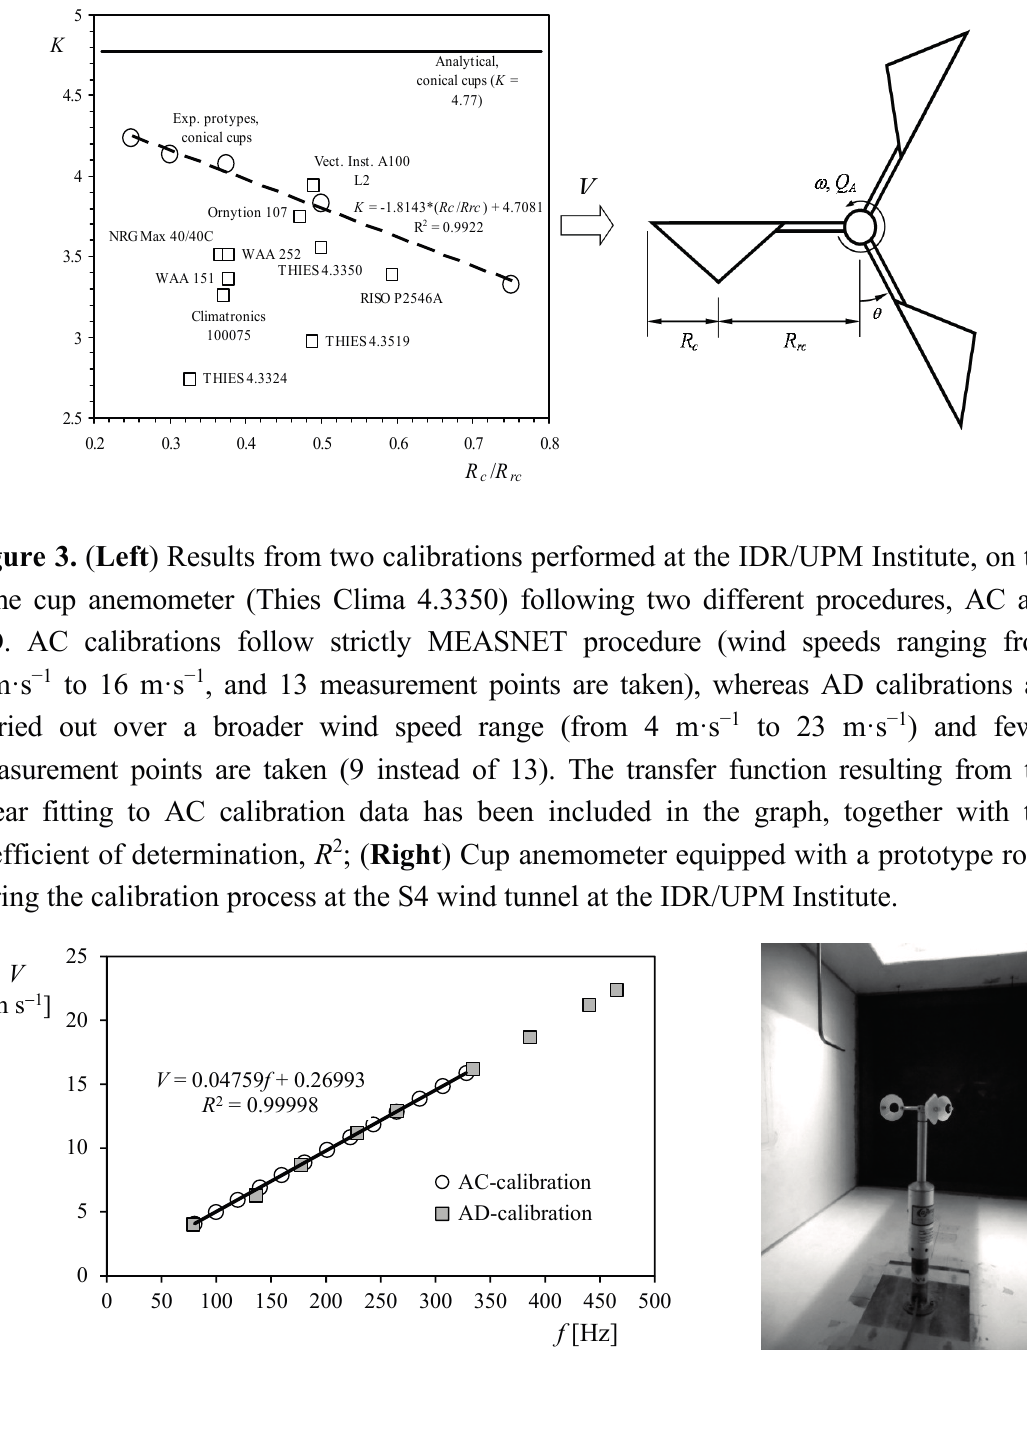
Figure 2. Cup anemometer factor, K (defined as K = V /2 π f r R rc , where V is the wind speed, f r is the anemometer’s rotation frequency, and R rc is the cups’ center rotation radius), as a function of the ratio between the cups’ radius, R c , and the cups’ center rotation radius, R rc (see sketch on the right side). Experimental results (white circles) were measured with a Climatronics 100075 anemometer equipped with conical cup rotors built with the same cup radius, R c = 30 mm, and by varying the cups’ center rotation radius, R rc . The linear fitting to these testing results has been added as a dashed line. The results from several commercial anemometers have been added to the graph, together with the analytical result calculated for the corresponding conical cups.